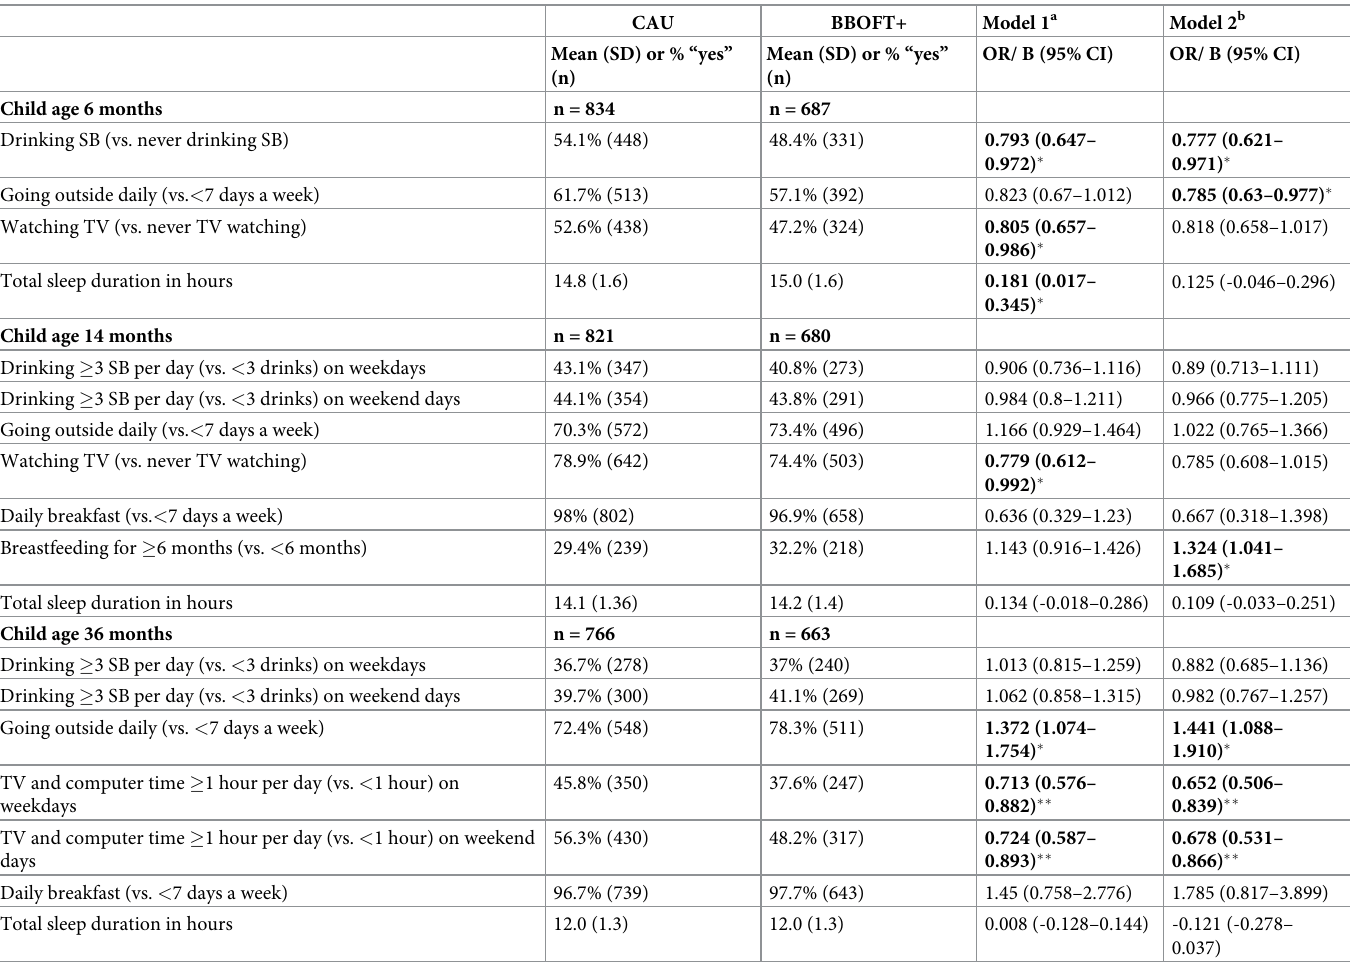
Table 4. Intervention effects on child health behavior at child age 6, 14 and 36